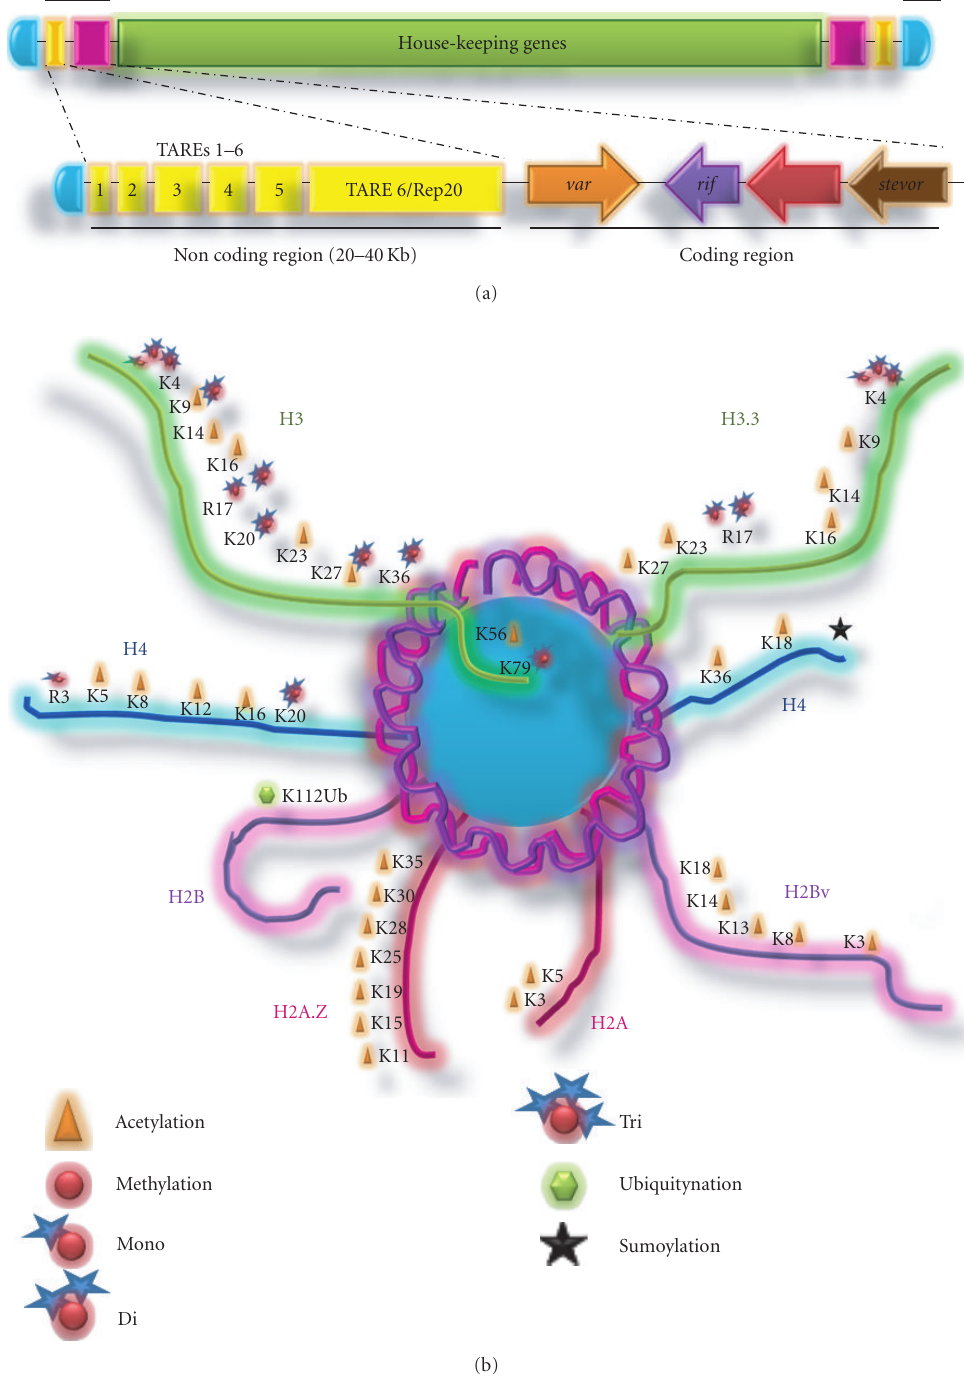
Figure 1: A model of P. falciparum chromosome organization. (a) The P. falciparum haploid nuclear genome is organized into 14 linear chromosomes. Each chromosome is composed of an internal region in which housekeeping genes are located, and a chromosome end that displays a higher-order DNA organization common to all P. falciparum chromosomes. Downstream of telomeres resides at highly polymorphic TAS composed of a noncoding and a coding region. The noncoding region contains six TAREs, which are always positioned in the same order but are of variable length. TARE6, also known as Rep20, is responsible for most of the length polymorphism observed in the noncoding region of the TAS. The coding region contains several gene families encoding important virulence factors, such as the var and rifin genes. (b) A schematic representation of post-translational histone modifications in P. falciparum . The amino acids on the N-terminal tails of histone H2A, H2B, H3, H4 and the histone variants H2A.Z and H3.3 that are subject to di ff erent modifications are described in the